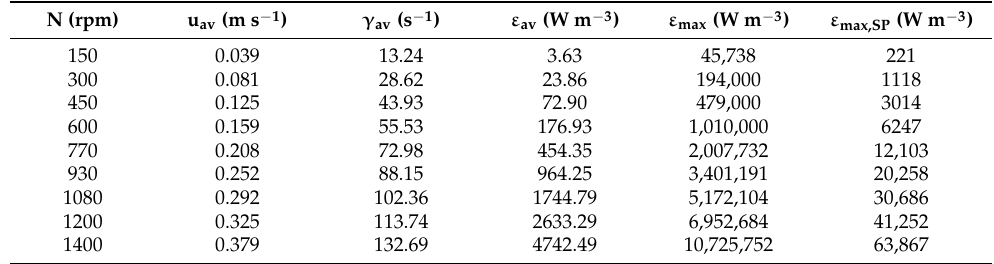
Table A2. Hydrodynamic parameters in the TIS based on CFD simulations. All values above 600 rpm were extrapolated linearly (velocity and shear rate) or quadratically, respectively (energy dissipation